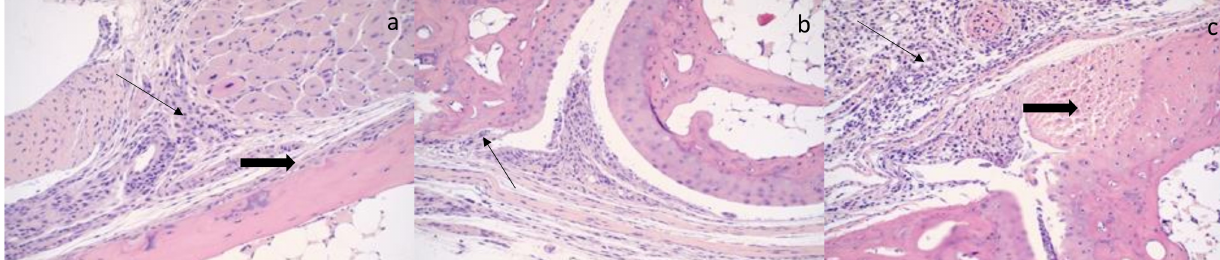
Figure 6. Histologic evidence of inflammation by 21 days post-infection (DPI) ( a – c ). ( a ) The histopathology reveals an active myositis with myofiber degenerative change. The lympho-histiocytic inflammatory infiltrate permeates the skeletal muscle (thin arrow) and extends to cortical bone, causing a periostitis with mild cortical bone erosion (thick arrow). ( b ) Section of joint active arthritis with an erosive lympho-histiocytic synovitis with articular cartilage scalloping and articular cartilage erosion with extension to cortical bone erosion (thin arrow). There is joint capsule inflammation, which extends into soft tissue. ( c ) Section of joint arthritis demonstrates an active lympho-histiocytic synovitis (thin arrow) with cartilage damage and erosion. The active joint inflammation shows extensive involvement and erosion of articular cartilage (thick arrow) with inflammatory extension of the joint